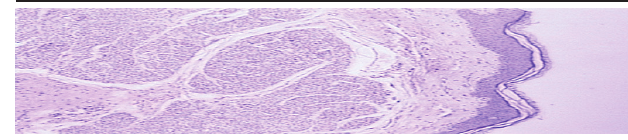
fIgure 1 – Vulvar melanocytic nevus; HE, 40× HE: hematoxylin and eosin.